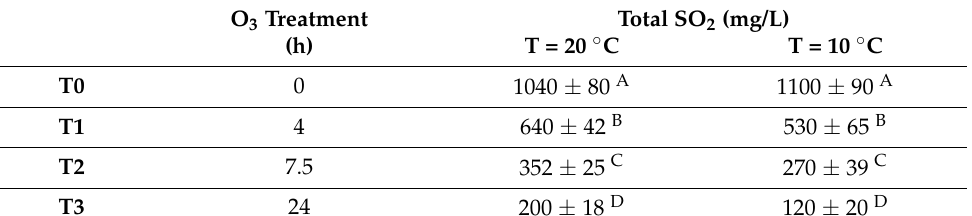
Table 1. Content of total SO 2 in red mute Lambrusco must treated with O 3 gas (8 µL/L) for the indicated treatment time, at 20 and 10 °C. Data are the mean of three glass jars, each temperature (±SE) in two replicated experiments. In the column, different capital letters indicate significance at p < 0.01.